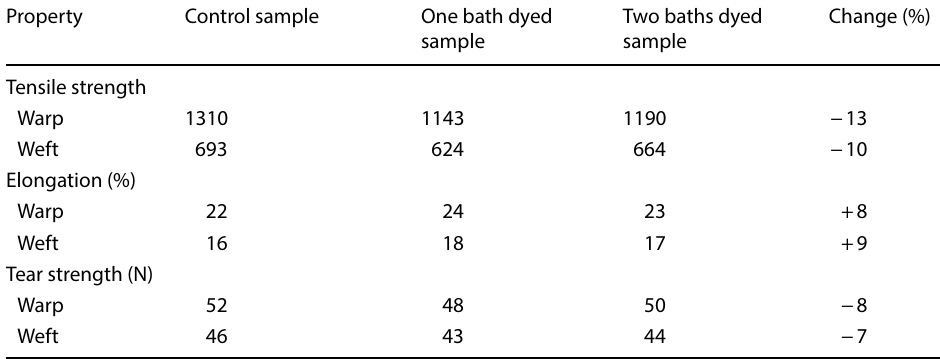
Table 7 Effect of treatment on physical properties of the